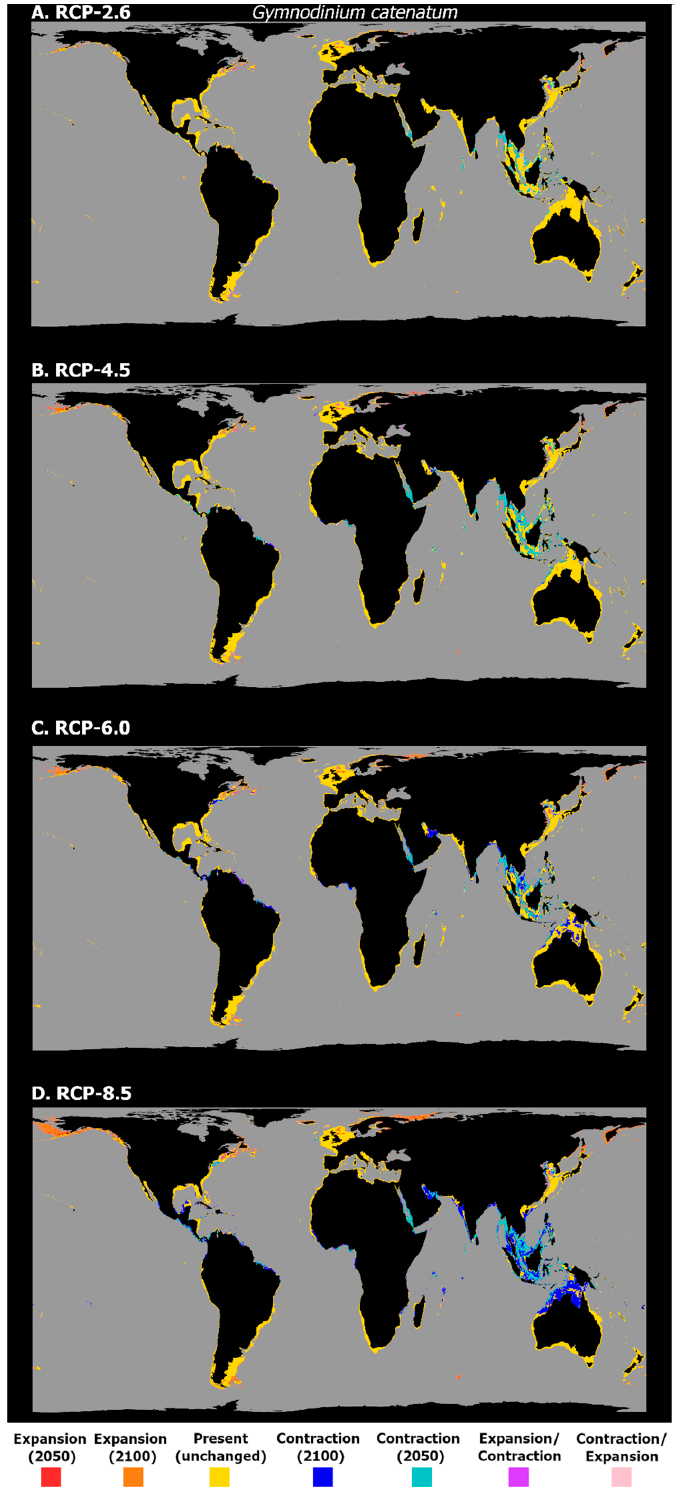
Figure 7. Projected distribution time maps for G. catenatum , showing predicted unidirectional range shifts in occurrence distribution [i.e., range expansion (in red and orange) or contraction (in dark and light blue)] as well as transitory fluctuations (i.e., range contraction followed by expansion (pink), and vice-versa (purple)), for each Representative Concentration Pathway scenario (RCP-2.6, 4.5, 6.0, 8.5; CMIP5). A larger, higher-quality version of this figure is present in the Supplementary Material (See “High_Res_Figures”